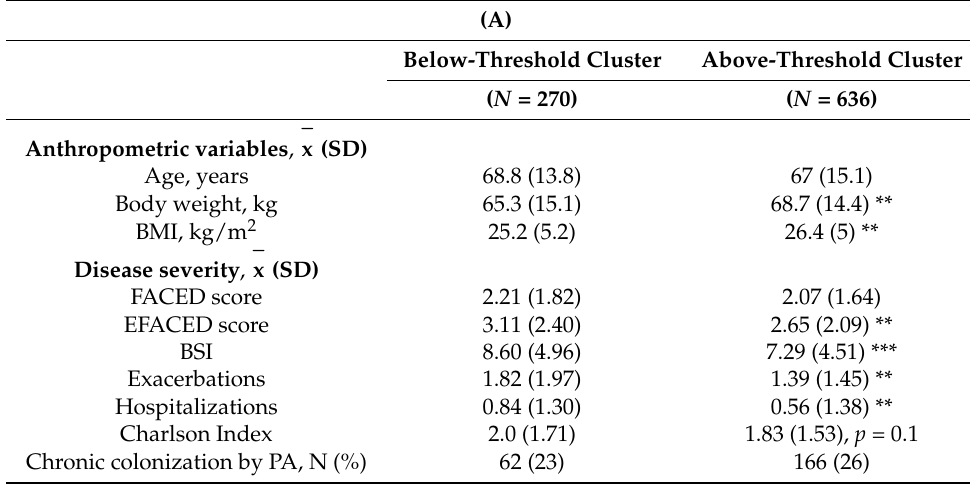
Table 1. ( A ) General characteristics of all the study patients. ( B ) General characteristics in the two clusters of bronchiectasis patients, excluding those with